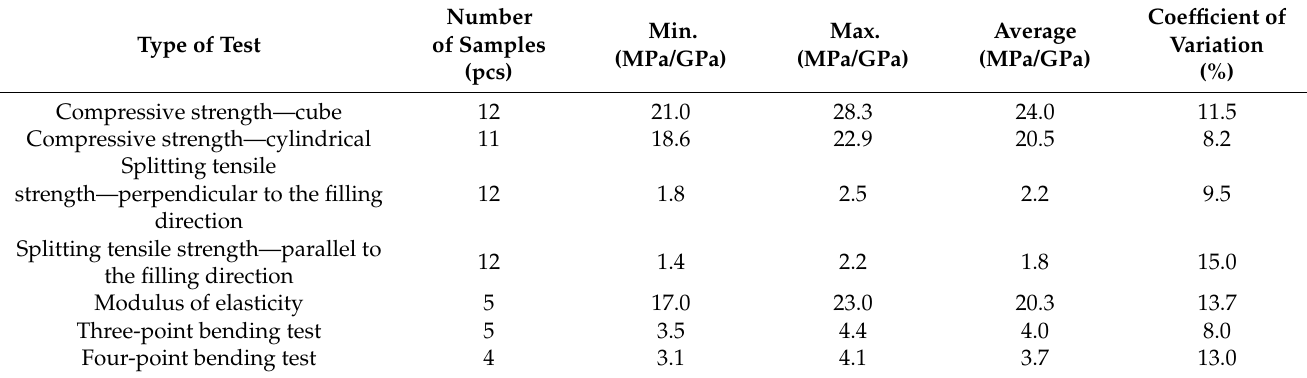
Table 3. Strengths of fiber-reinforced concrete determined from laboratory